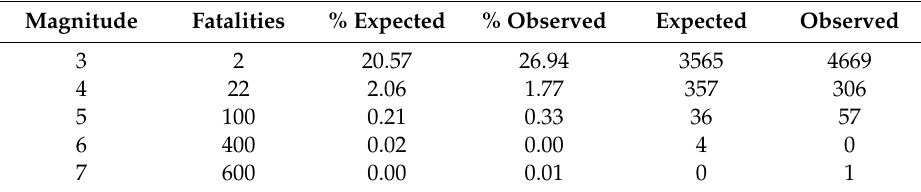
Table 2. The magnitude distribution of the social conflict data. For each magnitude there is the corresponding number of fatalities, the percentage of events expected by the Gutenberg–Richter law, the observed percentage of events, the expected absolute number of events and the observed absolute number of events. The full table appears in the Appendix